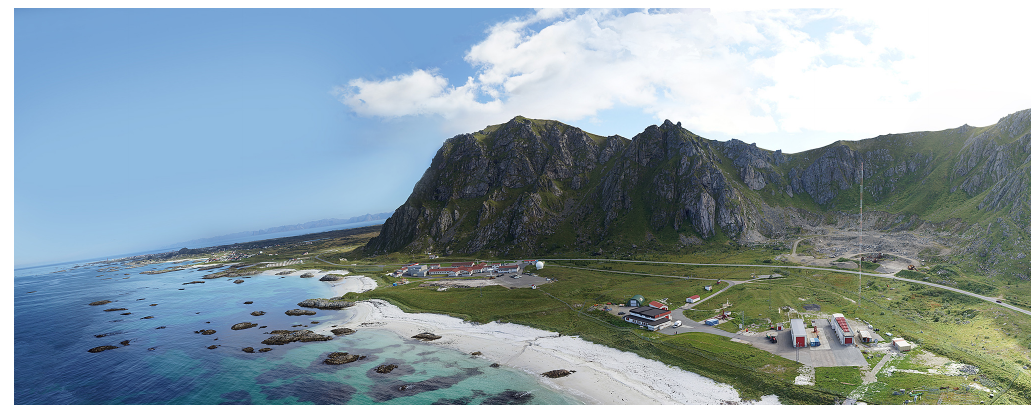
Figure 15. Panoramic view of ASC. Main buildings to the left, launch area to the right.